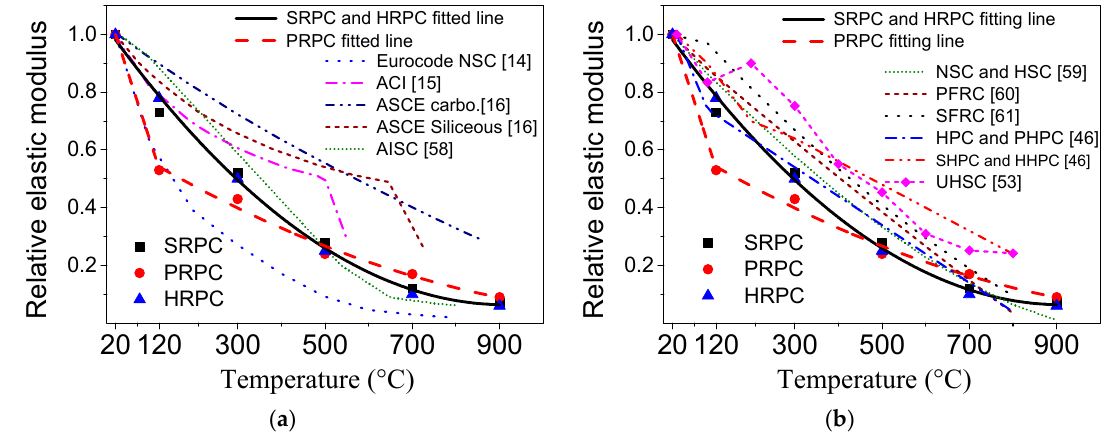
Figure 9. Comparison of the normalized elastic modulus of RPC with ( a ) design codes and ( b ) previous research.